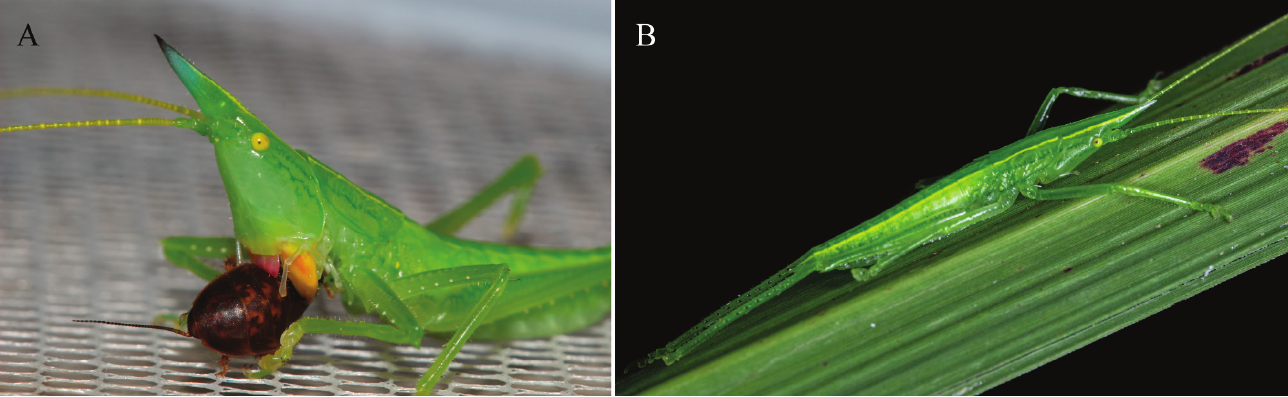
Fig. 5. Toledopizia salesopolensis in vivo. A, B. Male on bamboo leaf, green morph; C. Male on leaf, yellow morph.